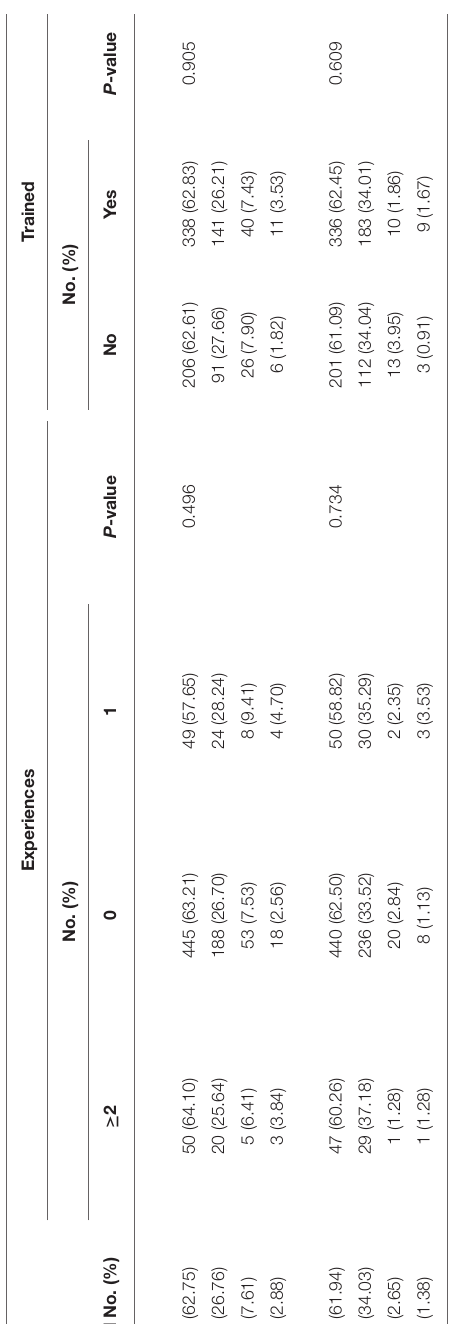
The median (IQR) scores on the PHQ-9 for depression and the GAD-7 for anxiety for all participants were 3.0 (1.0–6.0) and 4.0 (2.0–6.0), respectively. Consistently, participants who were younger, well-educated, and those who had fewer years of work experience had higher scores for both depression and anxiety [e.g., median (IQR) PHQ-9 scores among the younger (25–29)